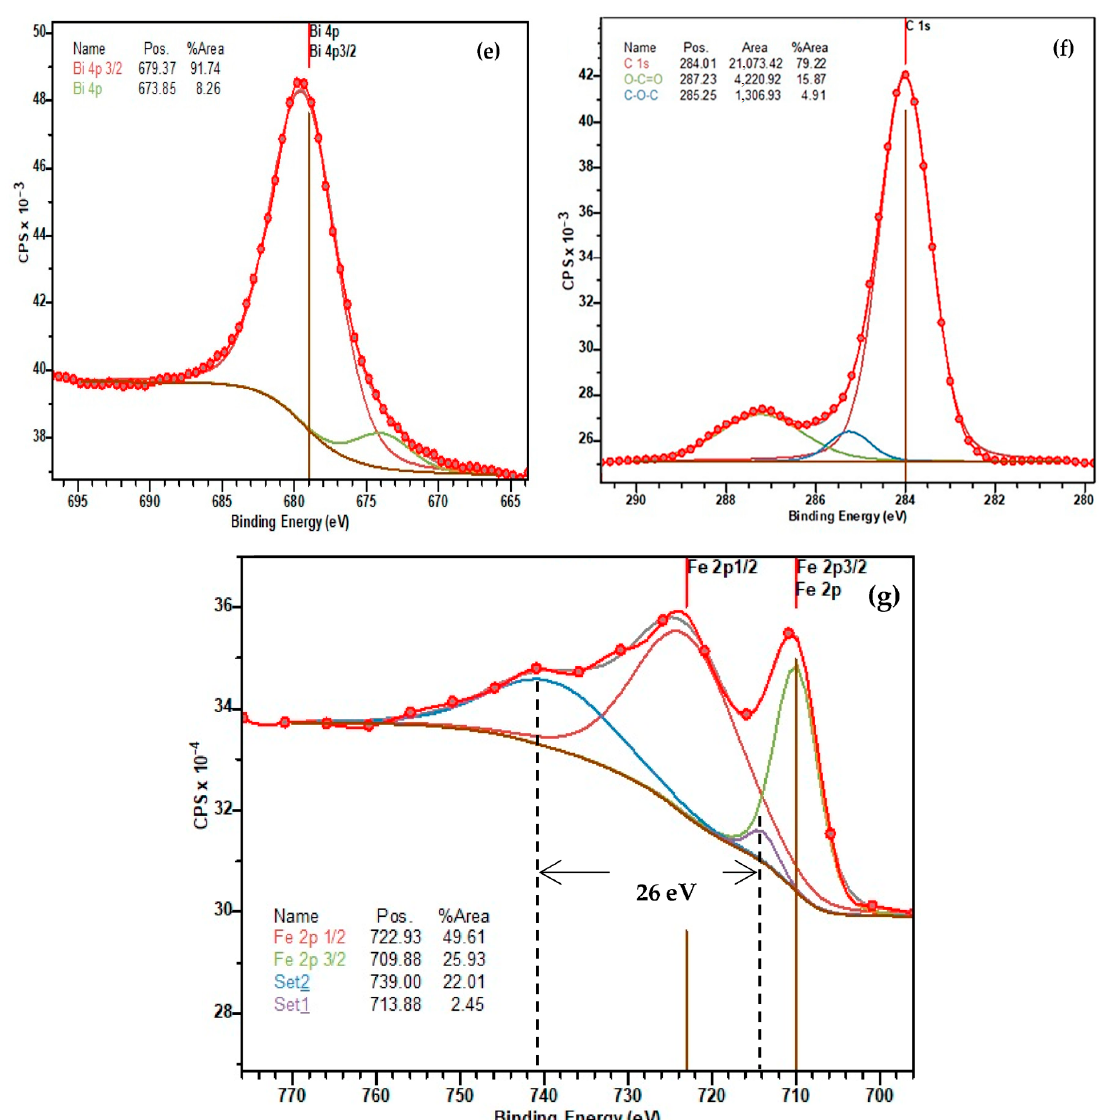
Figure 7. XPS spectra of individual elements ( a ) O 1s; ( b ) Bi 4d; ( c ) Bi 4f; ( d ) Bi 4s; ( e ) Bi 4p; ( f ) C 1s; ( g ) Fe 2p.